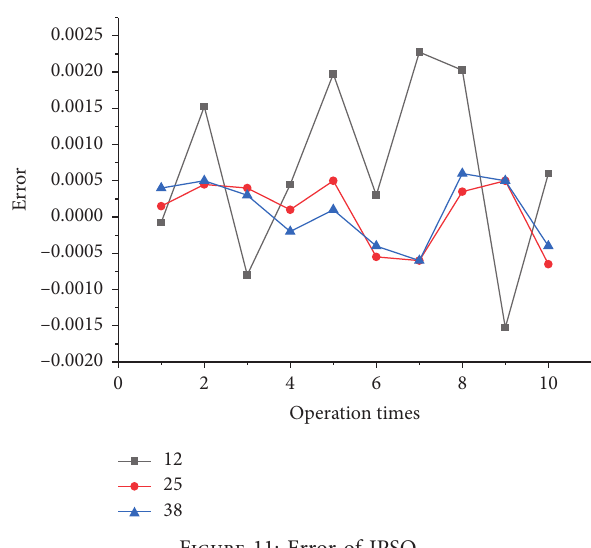
Figure 11: Error of IPSO.